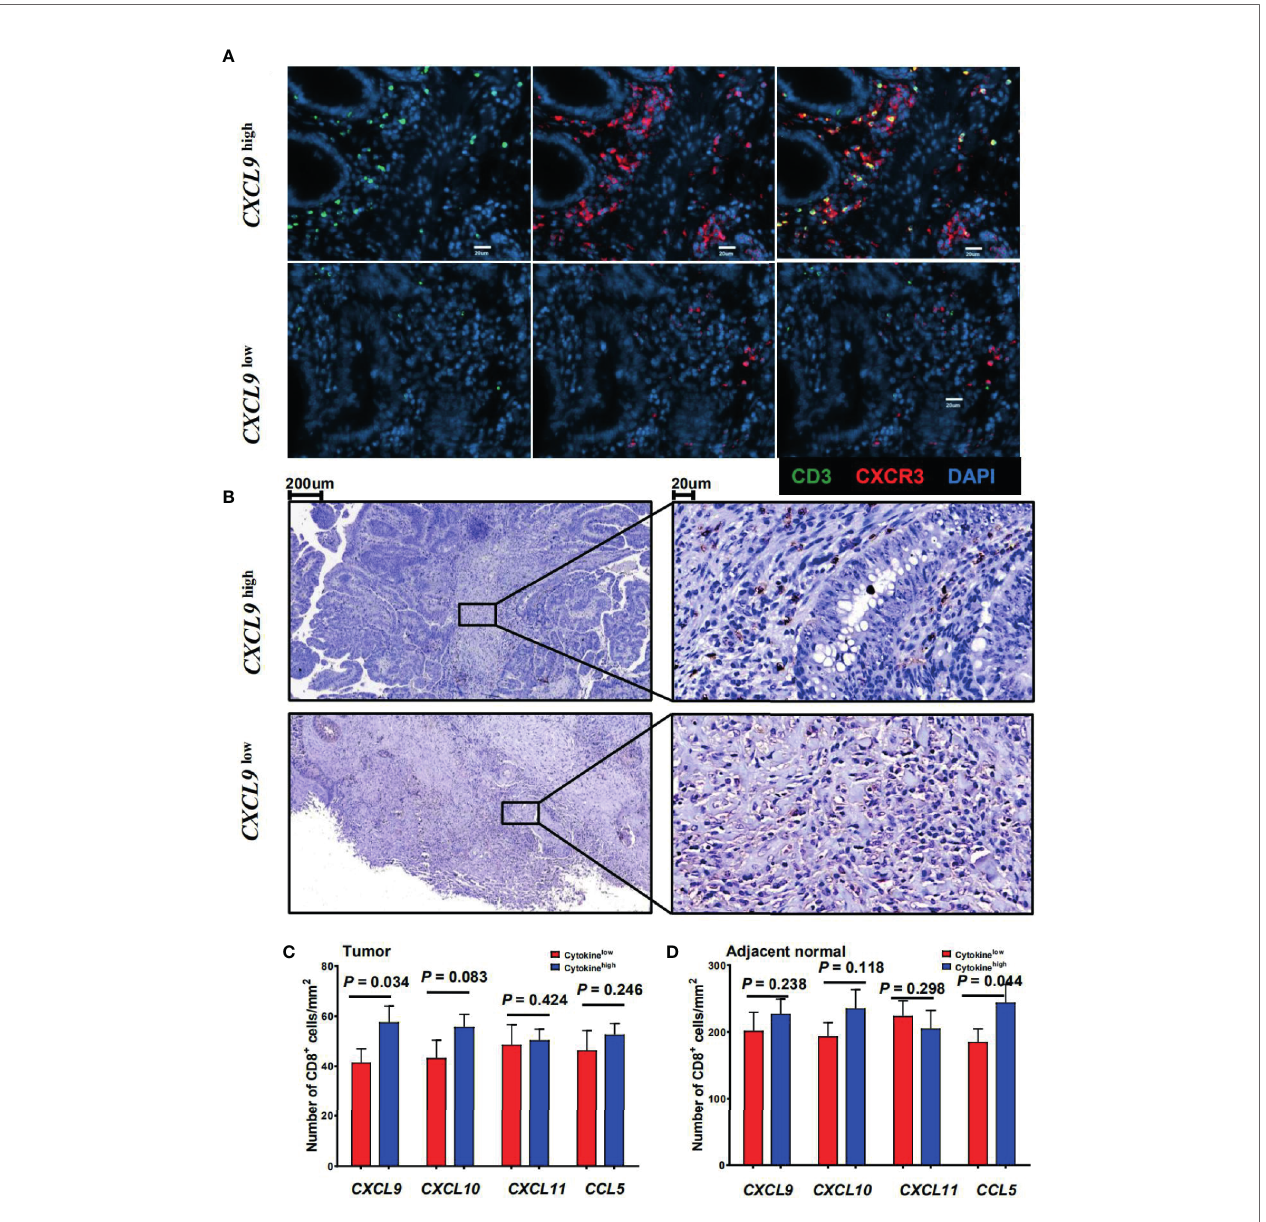
FIGURE 2 | Association between the cytotoxic T-cell traf fi cking chemokine expression and local CD8 + T-cell in fi ltration. (A) Immuno fl uorescence microscopy of CRC tissue sections from CRC patients with high or low CXCL9 expression levels, and stained with anti-CD3 (green) and anti-CXCR3 (red) monoclonal antibodies. (B) CD8 (brown) immunostaining of tumor tissues from CRC patients. Representative images of low (upper panel) or high (lower panel) CD8 score are shown. (C, D) Comparison of the mean ( ± SEM) of CD8 + cell densities in high (blue bars) and low (red bars) expression levels of individual chemokines within the tumor (left) or adjacent normal tissues (right) from CRC patients ( n =